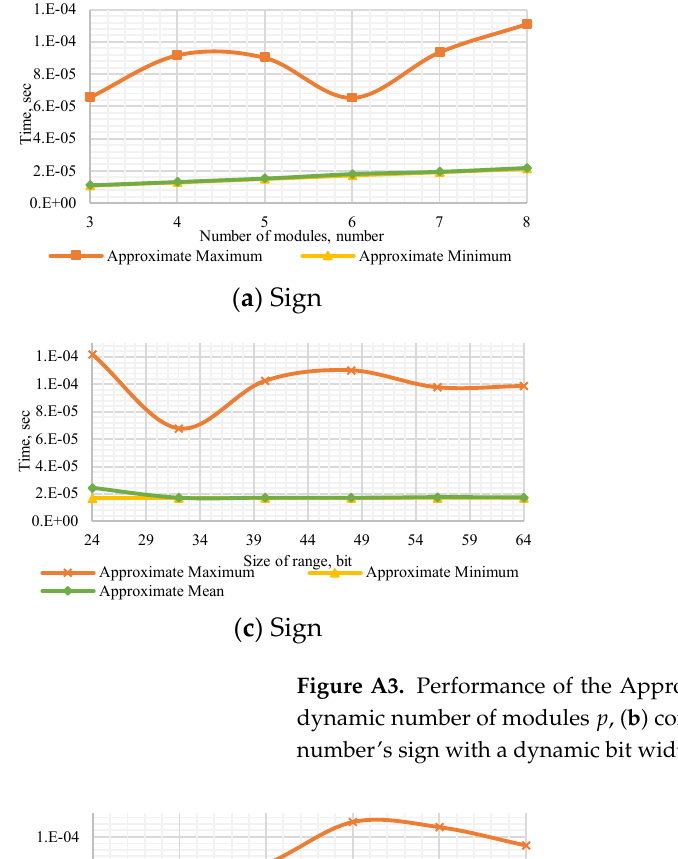
Figure A2. Performance of MRC method to ( а ) determine the number’s sign with a dynamic number